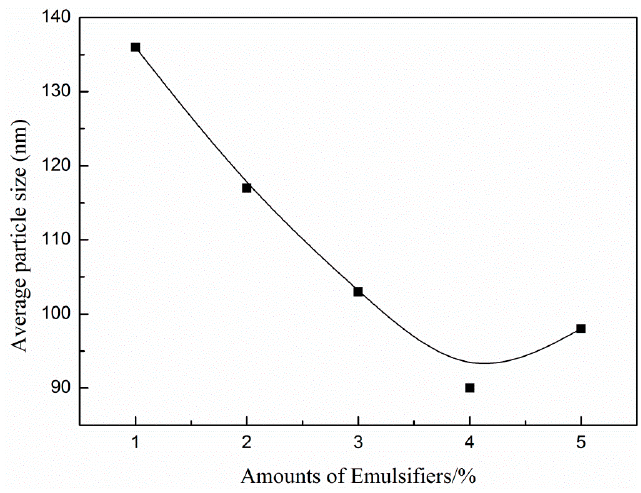
Figure 4. Effects of the DNS-86 amount on particle size.